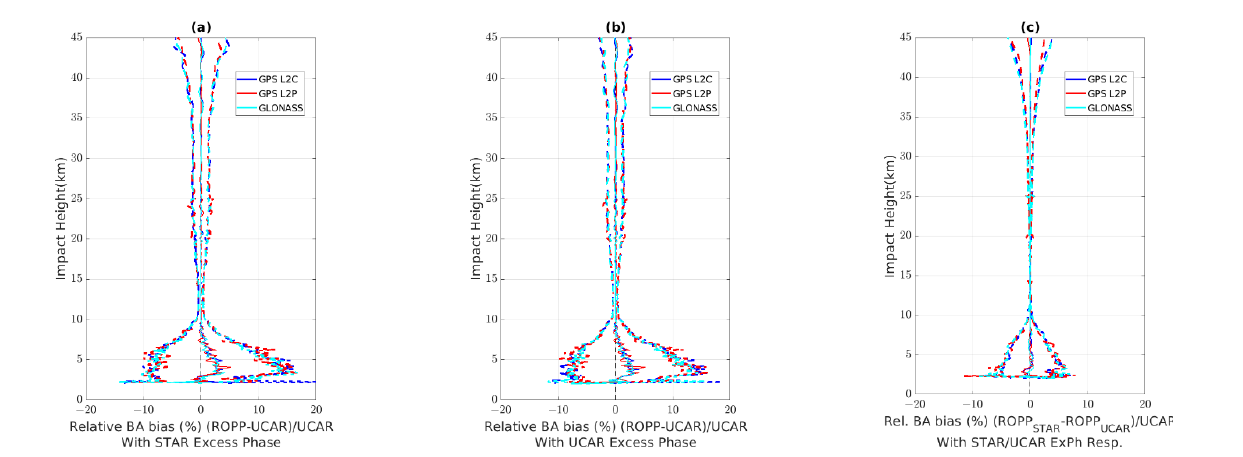
Figure 7. ROPP inverted bending angle profile comparison with UCAR bending angle profiles using ( a ) STAR derived excess phase, ( b ) UCAR provided excess phase, and ( c ) profile differences statistics (STAR).